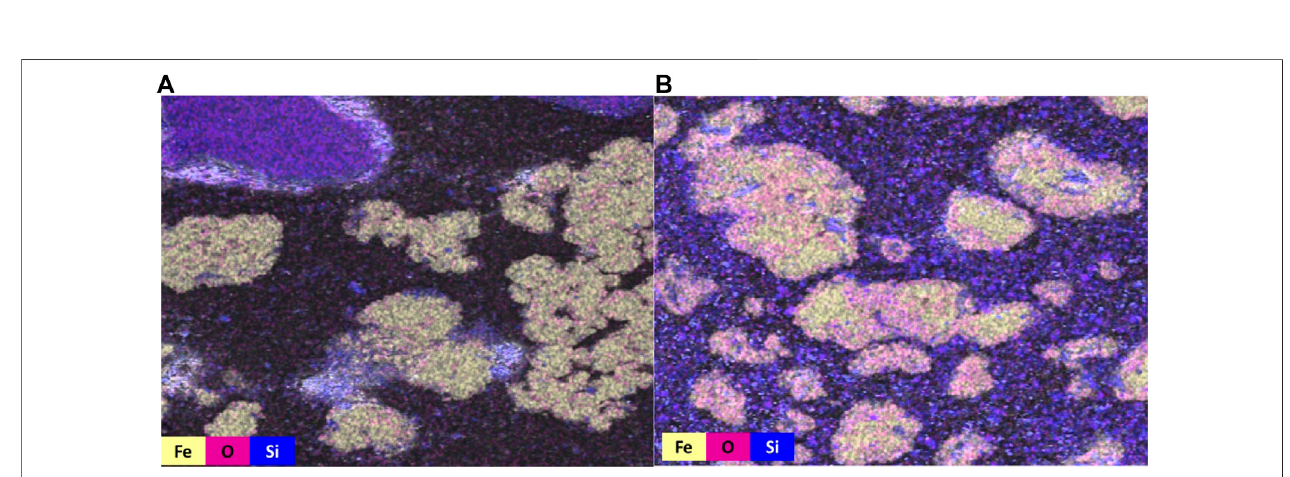
FIGURE 4 | SEM images of Iron-silica-3 (left) and Iron-silica-7 (right) .